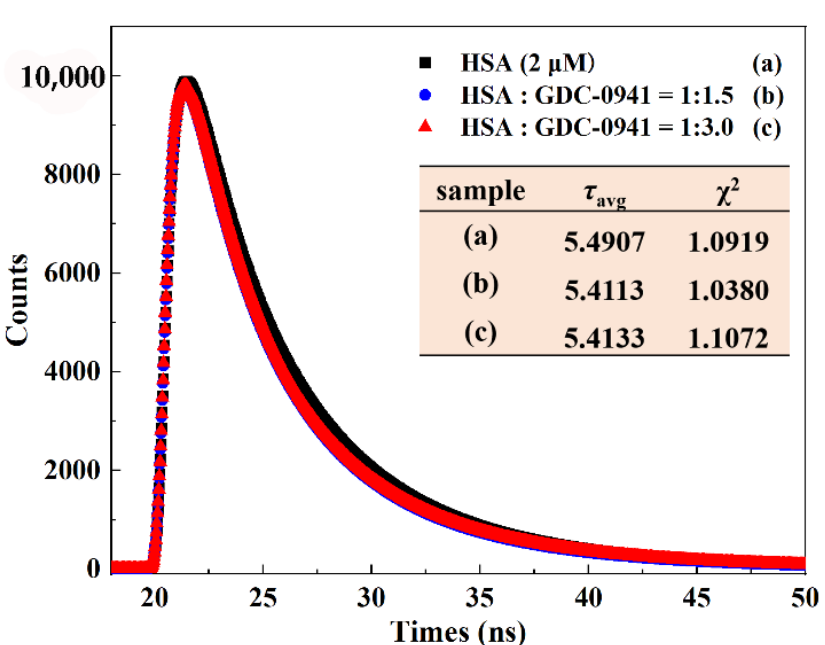
Figure 6. Time-resolved fluorescence lifetime of HSA (2 μ M) in the presence of various concentra- tions of GDC-0941 (0, 3, 6 μ M). of GDC-0941 (0, 3, 6 µ